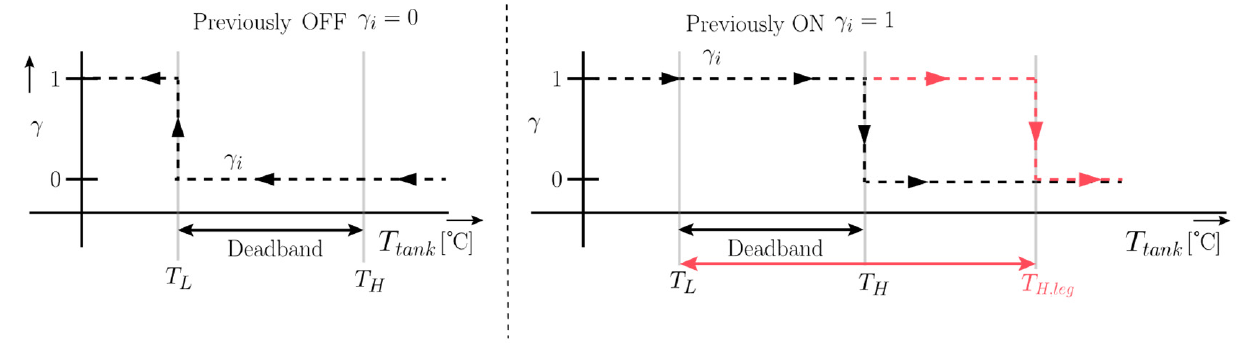
Figure 6. Control schematic of the temperature controller in the DHW tank.